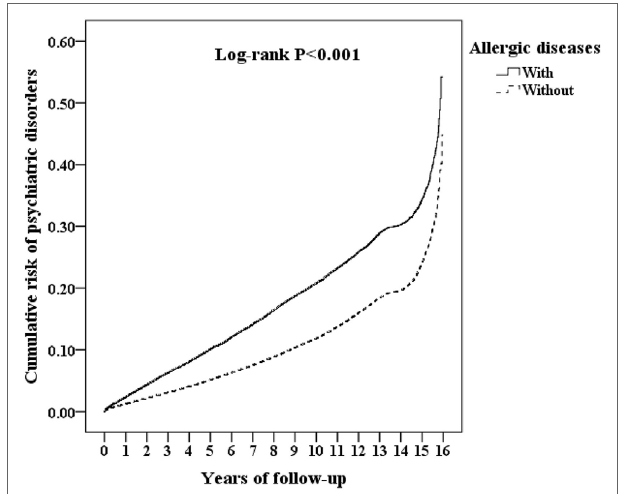
FigUre 2 | Kaplan–Meier for the cumulative risk of psychiatric disorders stratified by allergic diseases with the log-rank test.